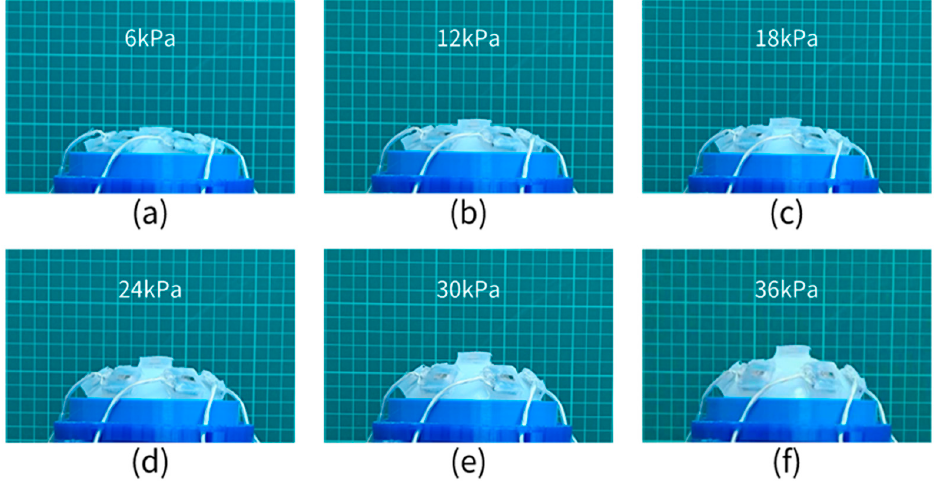
Figure 16. SAM experimental diagram, ( a – f ) represent the state recording diagram of the soft pneu- matic compound eye model at 6 kPa–36 kPa increasing at an interval of 6